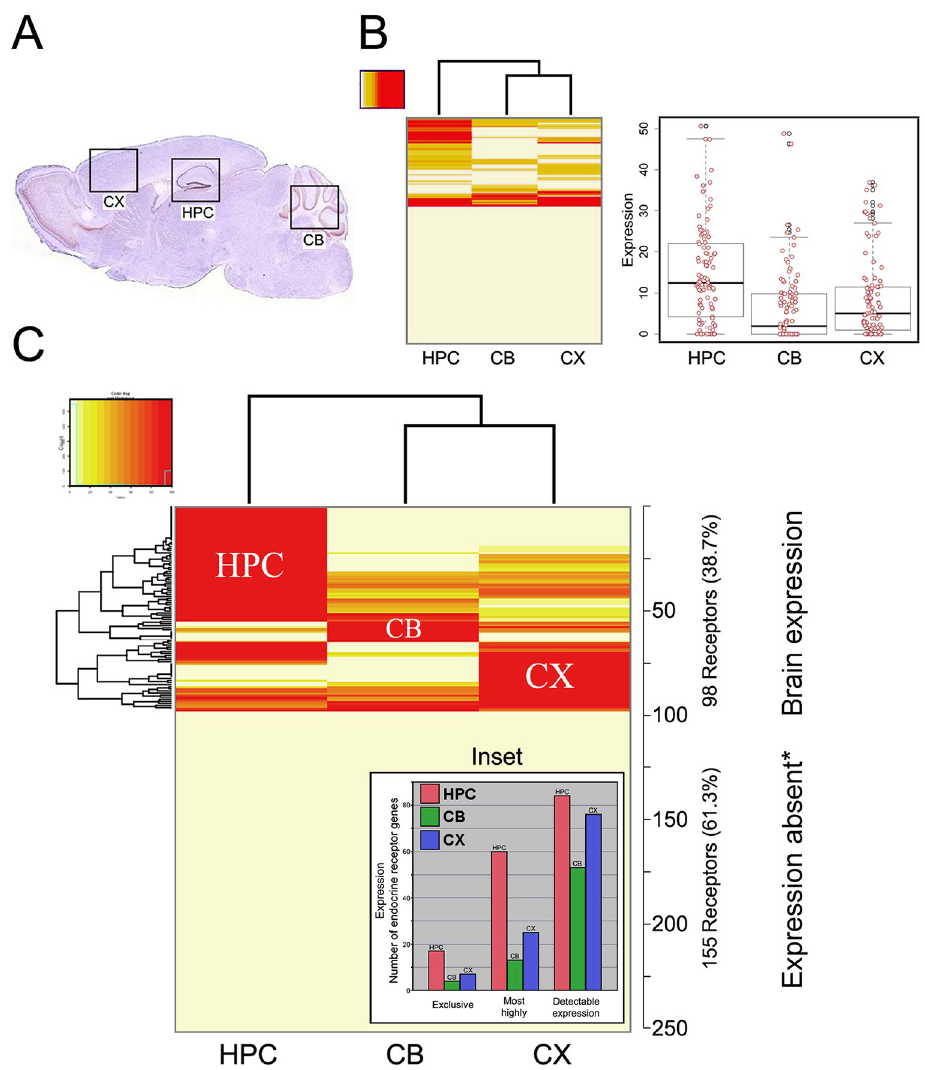
Fig 1. Endocrine receptor gene expression in mouse brain and enrichment in the hippocampus (HPC). More than one third of all endocrine receptors were detectably expressed in brain, where they are likely to modulate brain function and cognition. Expression was restricted to specific brain regions: other than hippocampus (HPC), cerebellum (CB), and cortex (CX), there was little evidence for specific gene expression in other comparable regions (~4%; see text). ( A ) Mouse brain section highlighting the three regions studied in detail: HPC, CB, and CX. ( B ) (Left) Heatmap of ’raw’ (unnormalized expression data, see Methods) for HPC versus CB and CX. (Right) Scatterplots of unnormalized expression levels; horizontal lines are medians and quartiles showing that the mean expression level of all receptors in HPC is significantly higher than in either CB or CX. ( C ) Normalized (maximum expression level = 100%) gene expression data. On three counts, the HPC (red), versus CB (green) and CX (blue), is the major site of expression of endocrine receptors (253 receptors examined) as further evidenced by the inset showing (i) exclusive expression in HPC, (ii) most prominent expression in HPC, (iii) overall number of receptors expressed. � Receptors showing no detectable expression or low-level/punctate/irreproducible expression are classified as expression absent. Note that the dendrograms (generated by heatmap.2), depicted in A and B, are not supported by statistical analysis versus alternative, competing dendrograms. Genes that are expressed exclusively in HPC, CB, or CB were not distributed among these three regions with equal probability, and ‘exclusive genes’ were expressed most often in HPC; the same result emerges when considering genes that are expressed most prominently in one brain region. Thus, the HPC expresses both a greater number and level of endocrine receptor genes than any other brain region